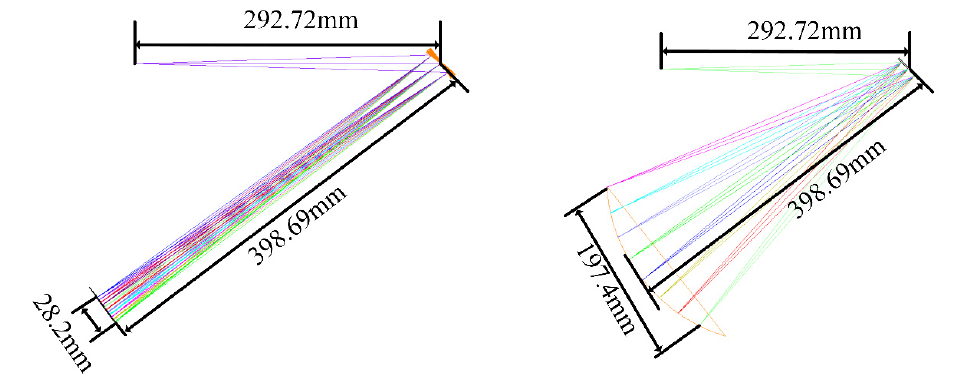
Figure 3. Size comparison of improved and traditional Paschen–Runge structured optical systems.